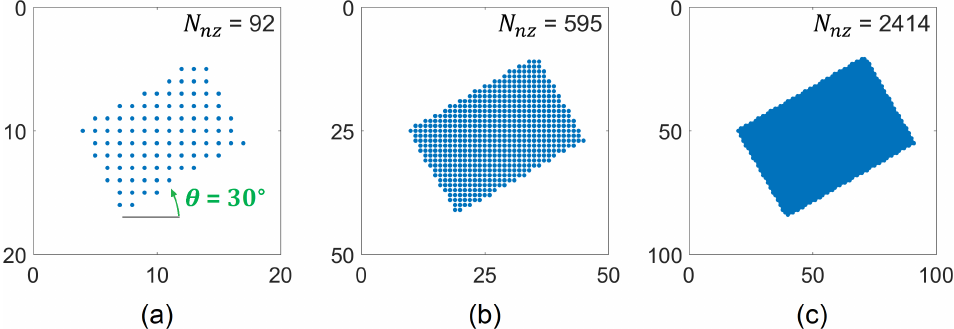
Figure 2. Sparsity patterns of a rectangle rotated by an angle of θ = 30 ◦ around its top-left corner for domain sizes of ( a ) 20 × 20, ( b ) 50 × 50, and ( c ) 100 × 100; which result in 92, 595, and 2414 nonzero entities, respectively. The rectangles have a size of ( h = 0.4 H , w = 1.5 h